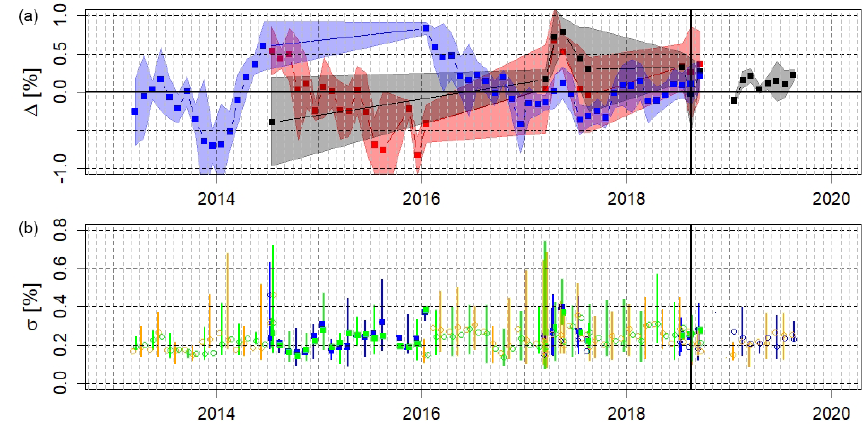
Figure 8. (a) Time series of the monthly median differences (%) between pairs of collocated Dobson instruments at Arosa over the period 2013–2019: (cid:49) 062–101 (red), (cid:49) 062–051 (blue) and (cid:49) 051–101 (black). (b) Time series of σ i monthly medians: σ 101 (blue), σ 062 (green) and σ 051 (orange). The shading and the error bars (plot every 2 months for clarity) denote the inter-percentile range IPR 97 . 5th–2 . 5th .